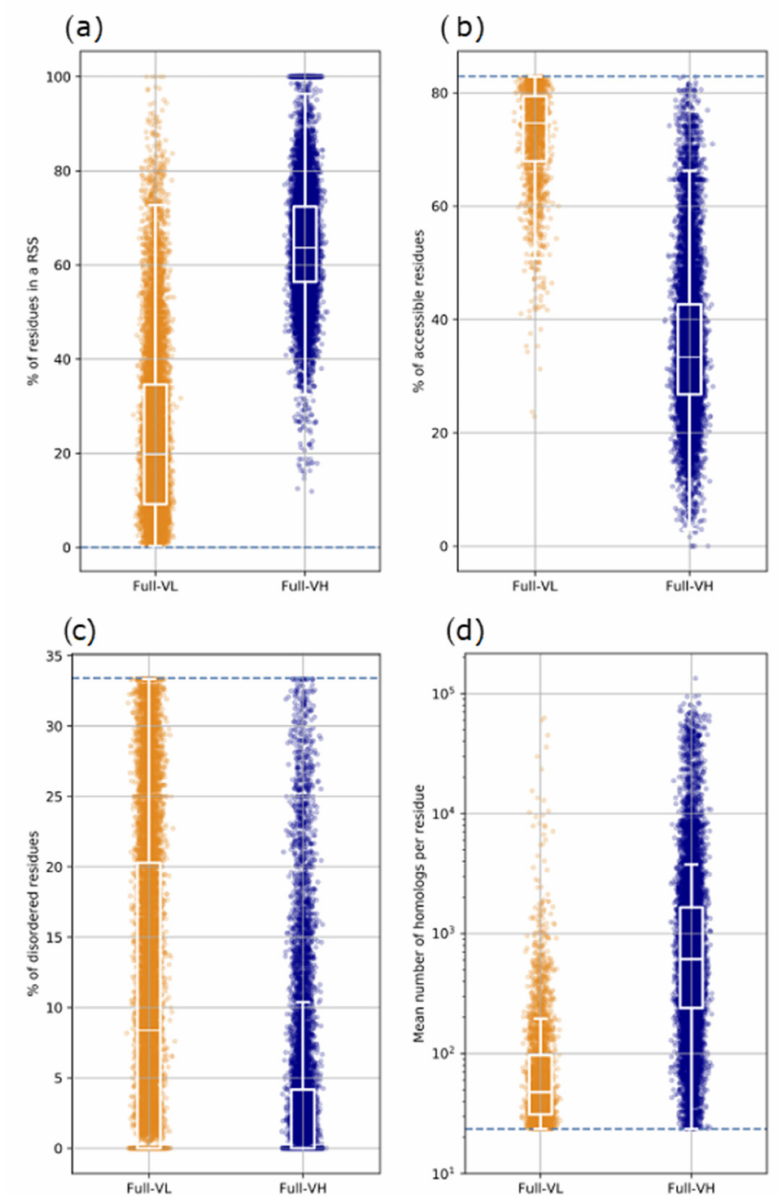
Figure 6. Distribution of features of 3D models and amino acid sequences for full-VH (blue) and full-VL (orange) long soluble-like foldable segments from AFDB v1 (21 proteomes). For the structural feature corresponding to the percentage of segment residues participating in a regular secondary structure (RSS) ( a ), only segments with at least 1 RSS as assigned by DSSP from the full-length protein 3D coordinates are shown (see Section 2 for quantitative details). For each feature in ( b – d ), the blue dashed line indicates the threshold value defined based on 95% of the full-VH segments (see Section 2 for details). For both full-VL and full-VH segments, only values falling in these intervals are shown. Such AF2 predictions cannot be reported with high confidence for several